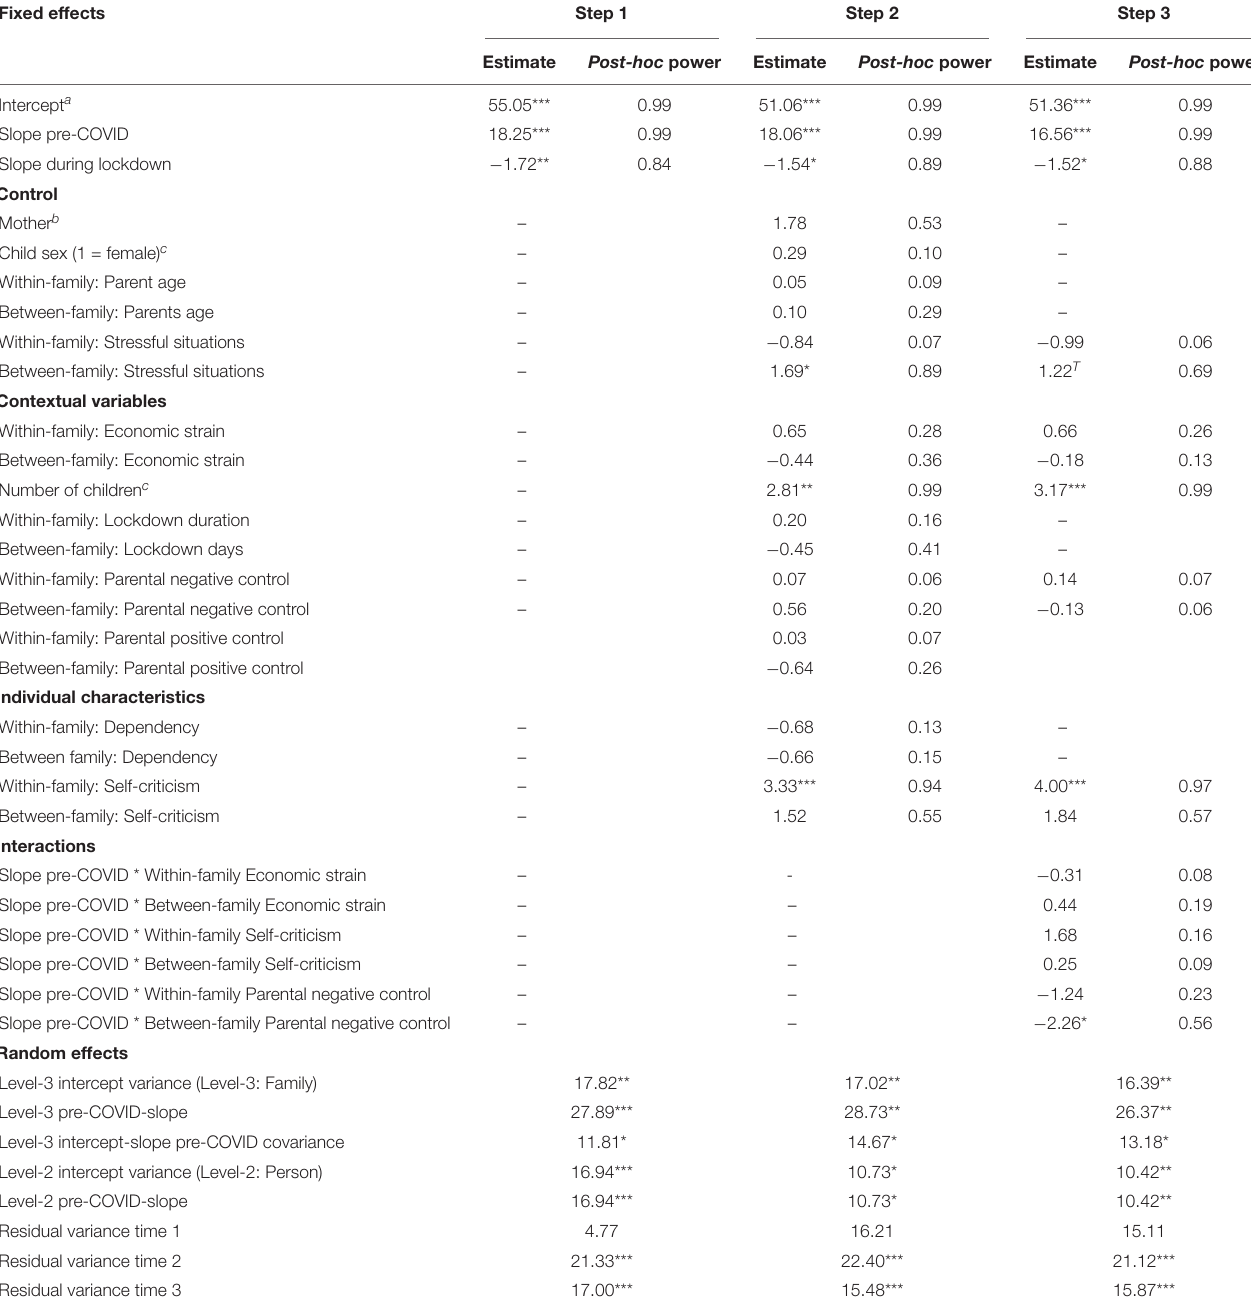
TABLE 5 | Model of individual and contextual variables on